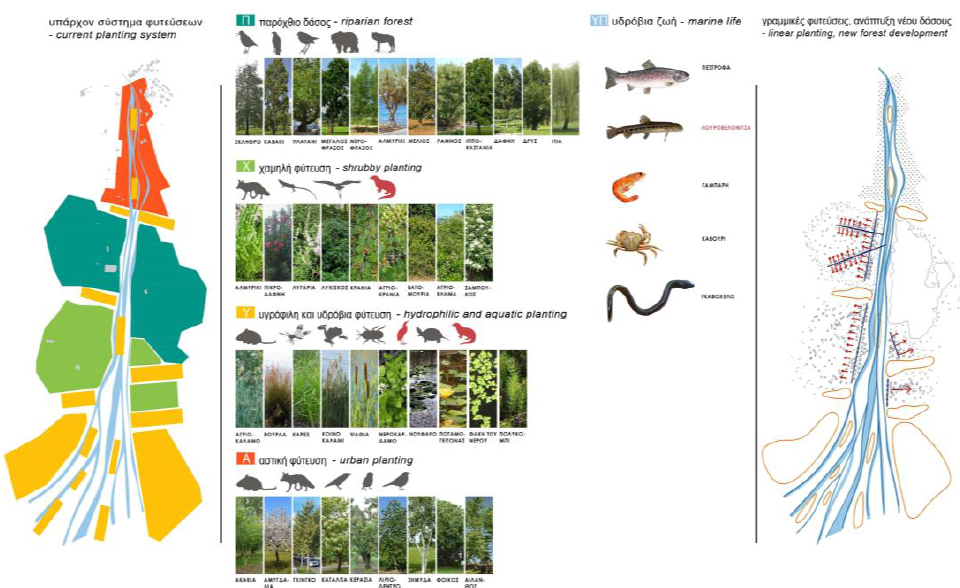
Figure 11. Sophia Kalakou, Maria Patmanidou, Carolos Galanos, Lena Sionti, and Yannis Zavoleas. Crossings of natural phenomena guiding hybrid urban/natural development strategies through dynamic mapping (right). Advanced urban design studio, University of Ioannina, 2022.